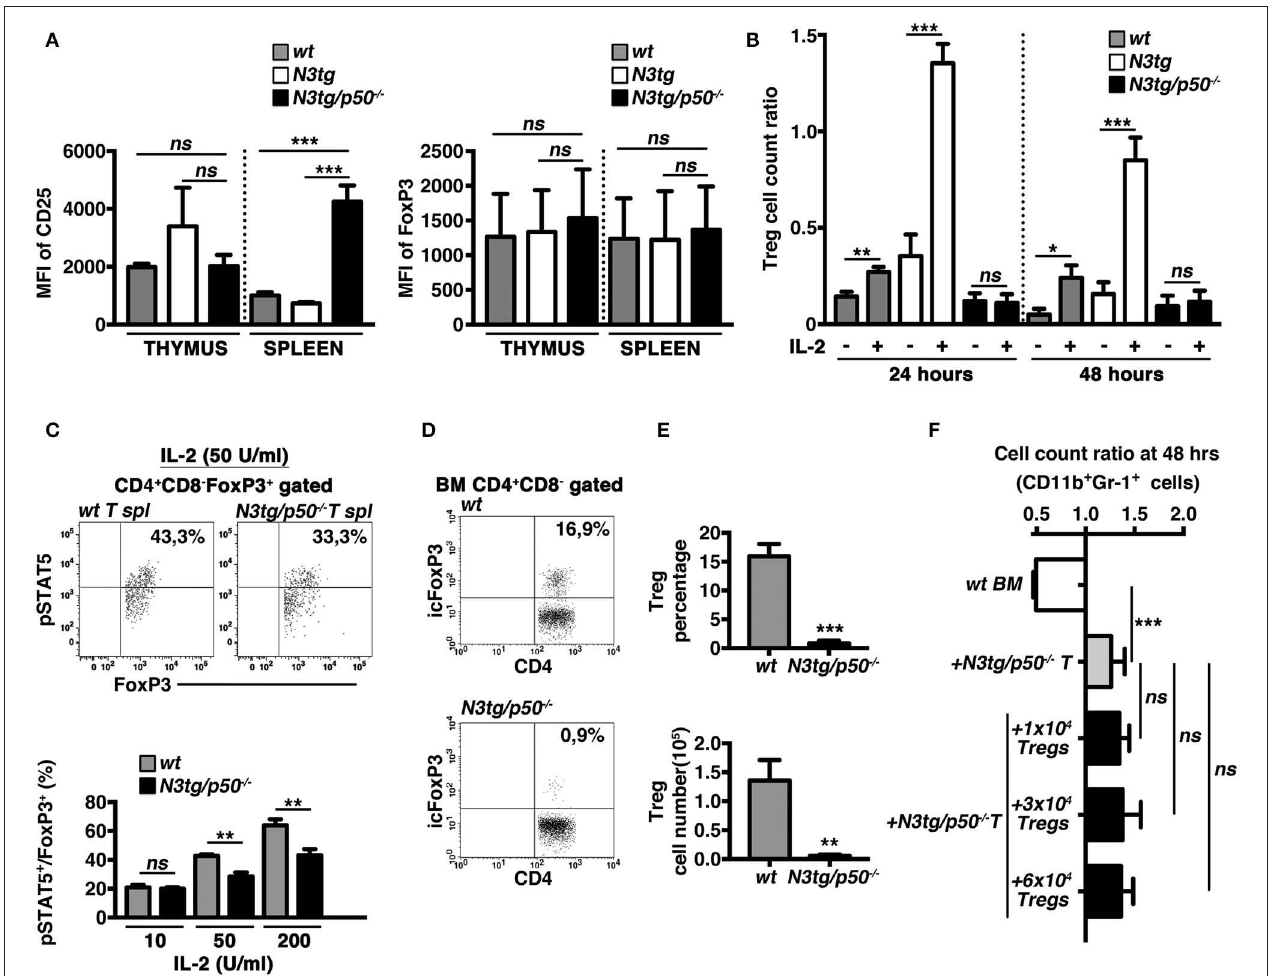
FIGURE 11 | The IL-2/STAT5 signaling is affected in Tregs from N3tg/p50 − / − mice. (A) The histograms represent the MFI of CD25 ( left panel ) and Foxp3 ( right panel ) in gated CD4 + CD8 − FoxP3 + subsets from thymus and spleen of wt , N3tg , and N3tg/p50 − / − mice at 4–5 weeks of age. (B) The graph represents the ratio of the Treg cell count at 24 or 48h and the related Treg cell count at 0h in culture samples of T splenocytes from N3tg/p50 − / − , N3tg , or wt mice at 4–5 weeks of age, in the absence (–) or presence ( + ) of anti-CD3/IL-2 stimulation. In (A,B) the values are presented as mean ± SD of three independent experiments ( n = 3 mice per group). ns, not significant; * P ≤ 0.05, ** P ≤ 0.01, and *** P ≤ 0.001 represent significant differences between the indicated groups. (C) In the upper panels , representative FACS analysis of pSTAT5 expression inside CD4 + CD8 − FoxP3 + subset of total T splenocytes ( T spl ) from N3tg/p50 − / − and wt mice at 4–5 weeks of age, upon activation with 50 U/ml of rhIL-2. Numbers inside each cytogram represent the percentages of pSTAT5 + FoxP3 + cells inside gated CD4 + CD8 − FoxP3 + subset. In the lower panel the graph represents the percentages of pSTAT5 + FoxP3 + cells inside CD4 + CD8 − FoxP3 + compartment of total T splenocytes from wt and N3tg/p50 − / − mice at 4–5 weeks of age, following the activation with rhIL-2, at the indicated doses. Samples stained without rhIL-2 stimulation served as negative control (not shown). The values are presented as mean ± SD of three independent experiments ( n = 3 mice per group), in triplicates. ns, not significant; ** P ≤ 0.01 represents significant differences between the indicated groups. (D) Representative dot plots of icFoxP3/CD4 distributions inside gated CD4 + CD8 − T cells from BM of N3tg/p50 − / − vs . wt mice at 4–5 weeks of age, as assessed by FACS analysis. Percentages of FoxP3 + CD4 + cells are indicated inside each cytogram. (E) Mean percentage values ( upper panel ) and absolute numbers ( lower panel ), of Foxp3 + Tregs inside the CD4 + CD8 − subset in the BM from N3tg/p50 − / − and wt mice, assessed as in (D) . The values are presented as mean ± SD of three independent experiments ( n = 3 mice per group). ** P ≤ 0.01, *** P ≤ 0.001 represent significant differences between the N3tg/p50 − / − samples and the relative wt controls. (F) The graph represents the ratio of the CD11b + Gr1 + cell count at 48h to the related CD11b + Gr1 + cell count at 0h in wt BM cells cultured alone ( wt BM ), as a basal control, in the co-cultures of wt BM cells with T splenocytes from N3tg/p50 − / − mice ( + N3tg/p50 − / − T ), as well as in the co-cultures of wt BM cells with T splenocytes from N3tg/p50 − / − mice in the presence of different numbers of CD4 + CD8 − EGFP + Tregs purified from the spleen of the Foxp3EGFP “knock-in ” reporter mice ( + N3tg/p50 − / − T + 1 × 10 4 /3 × 10 4 /6 × 10 4 Tregs). Data represent the mean ± SD of three independent experiments ( n = 3 mice per group), each in triplicates. ns, not significant; *** P ≤ 0.001 represents significant differences between the indicated